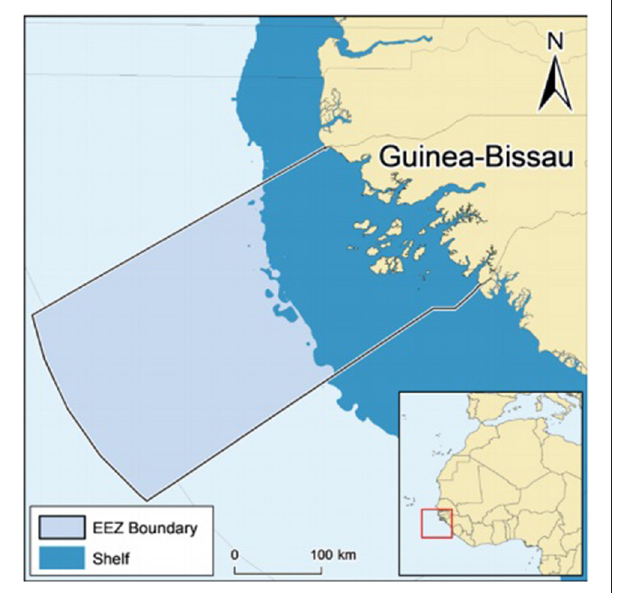
FIGURE 1 | Map of Guinea-Bissau with its Exclusive Economic Zone (EEZ).